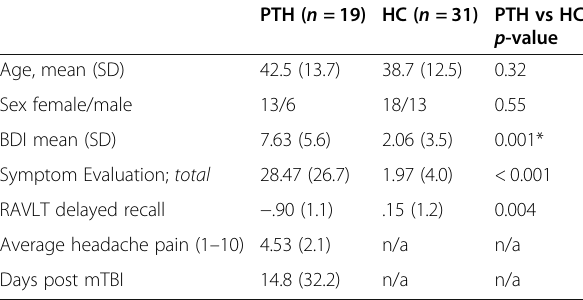
Table 2 Subject Demographics. Average headache pain = ranges from 1 to 10 (1 = mild headache to 10 = worst headache imaginable) BDI=Beck Depression Inventory, mean raw score; SCAT-3 = Sport concussion assessment tool (SCAT-5), Symptom Evaluation, total score; RAVLT delayed recall = Ray Auditory Verbal learning test, delayed recall, z-score; Days post-mTBI = number of days between the date of mild traumatic brain injury and the date of the baseline visit, on average, patients with PTH were seen two-weeks post-concussion (14.8 days, range 4 – 42 days); HC = healthy controls; n/a = not applicable; PTH=Post- traumatic